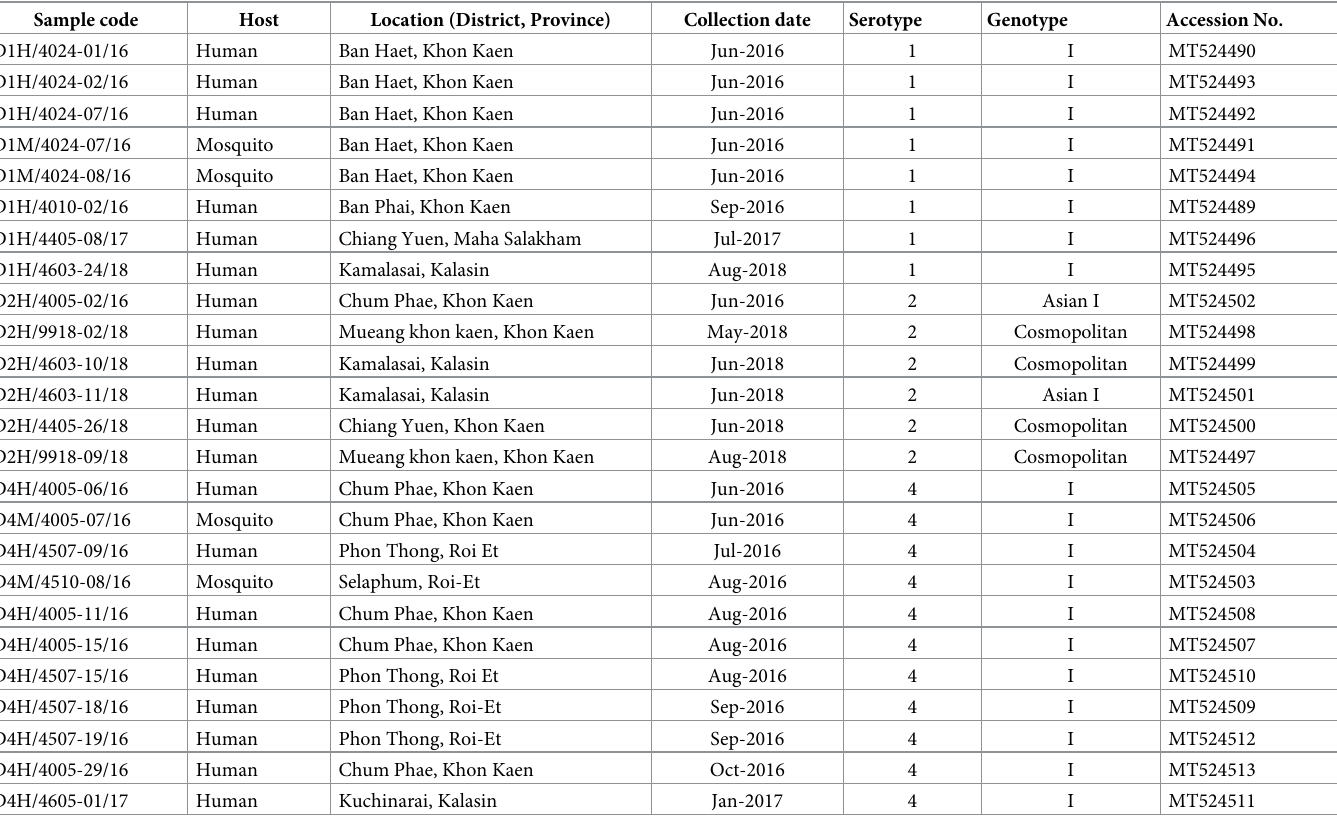
Table 1. Information on dengue virus strains in this study. Sample